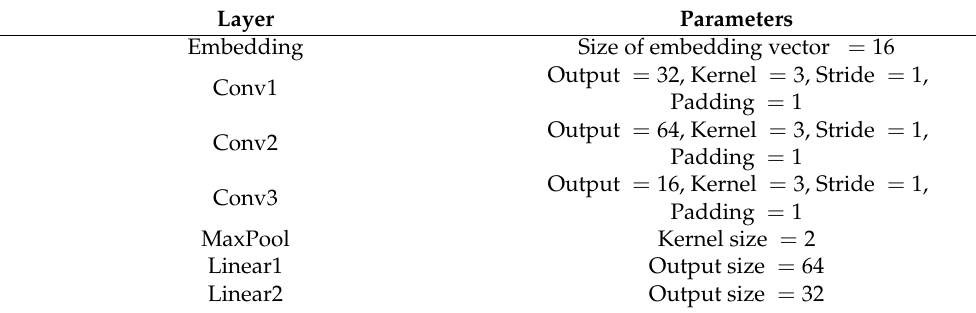
Table 3. Global policy network